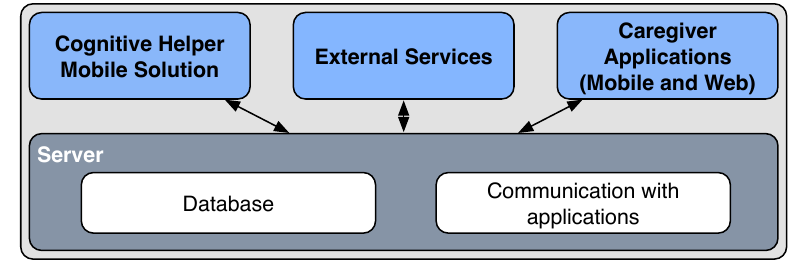
Figure 1. Simplified Framework of